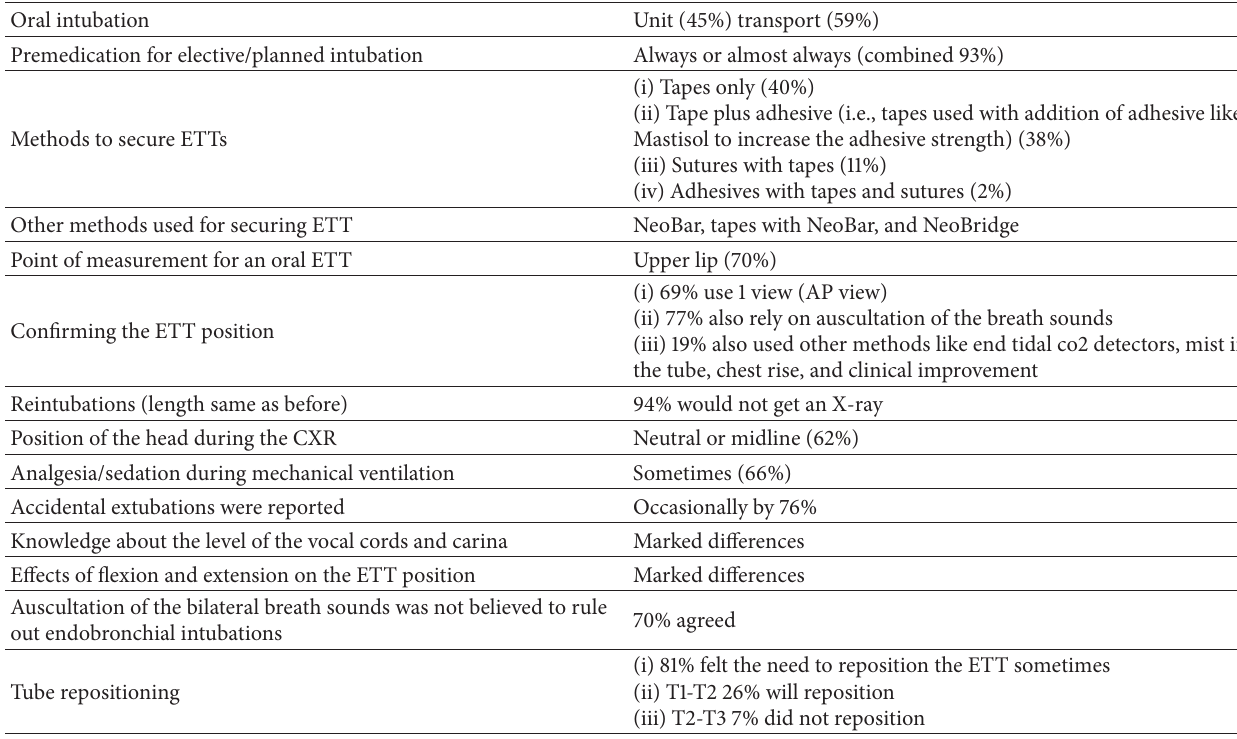
Table 4: Preferred